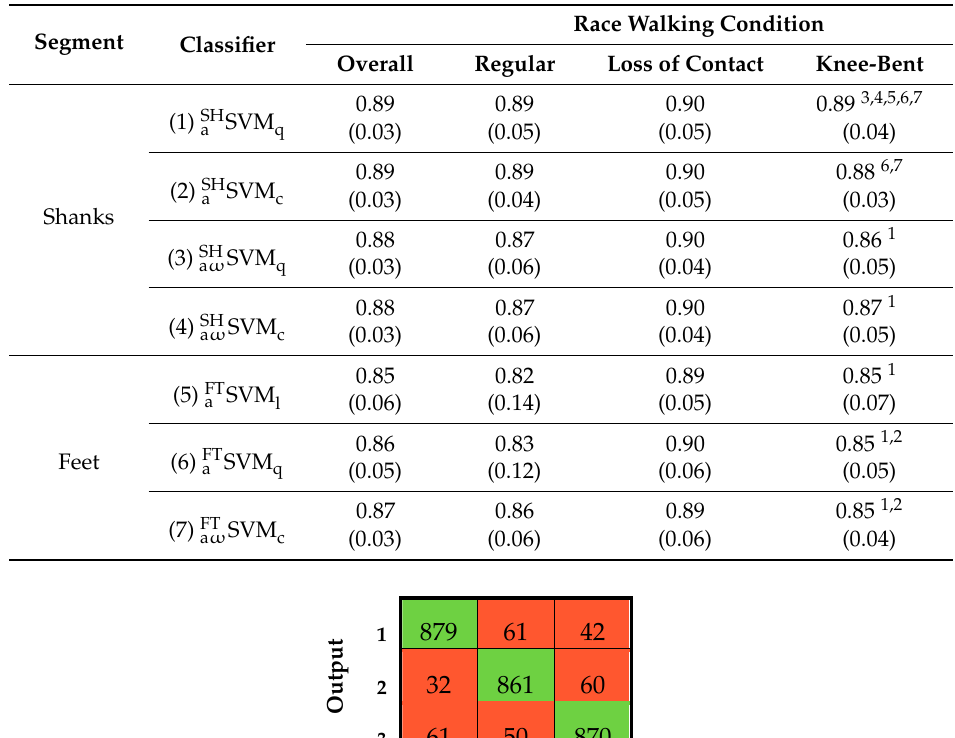
Table 6. Mean and standard deviation of the F1-score for both the overall classification and each race walking condition. Superscripts indicate statistical differences among classifiers.